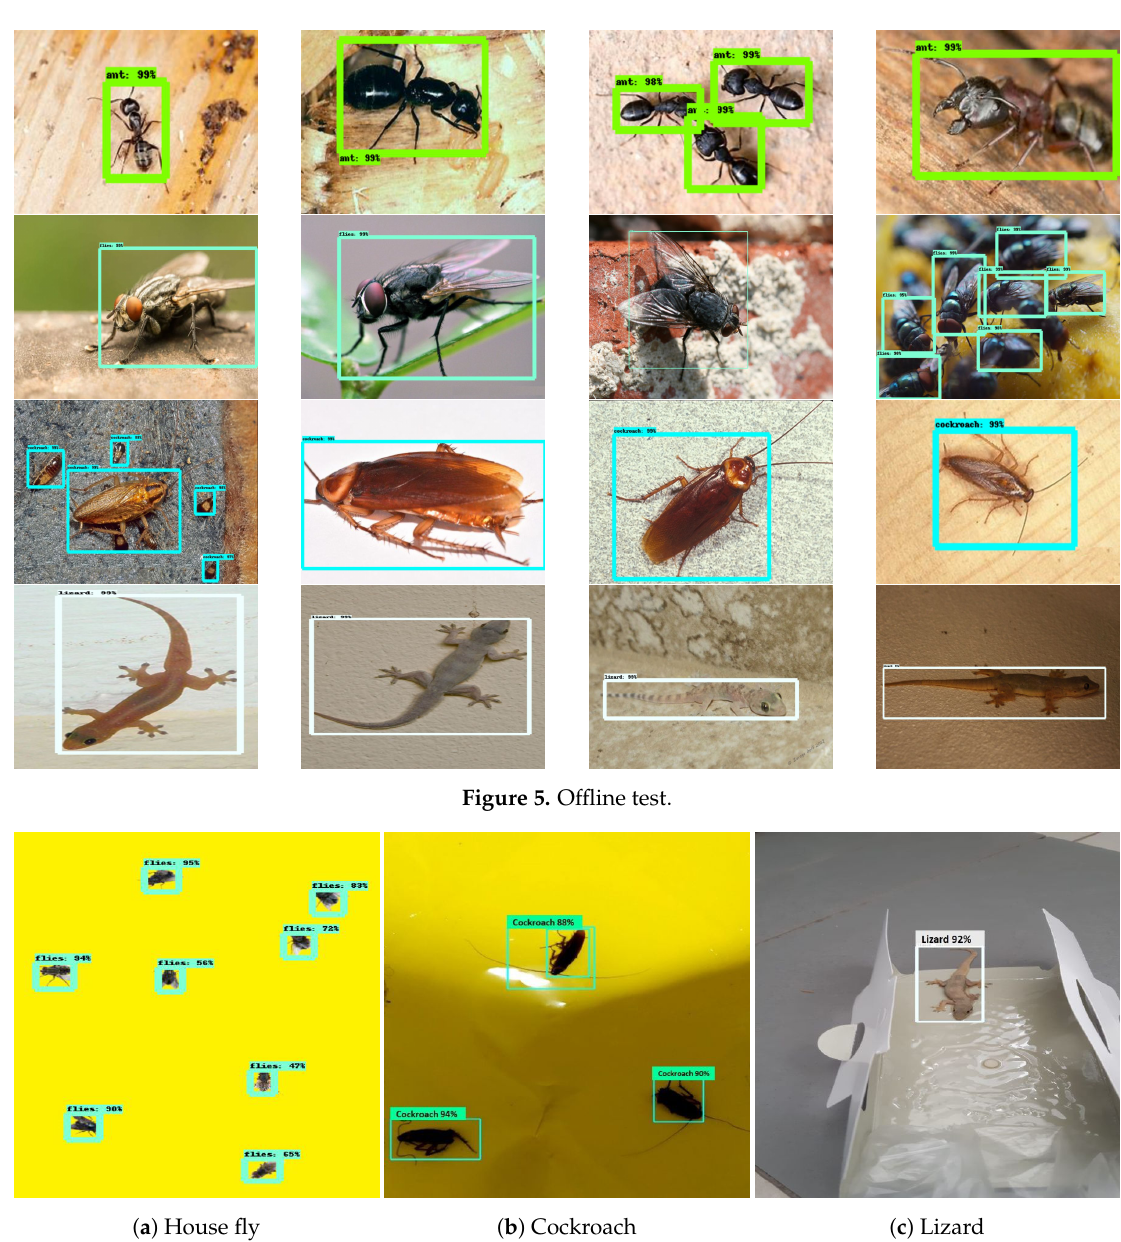
Figure 6. Real time test